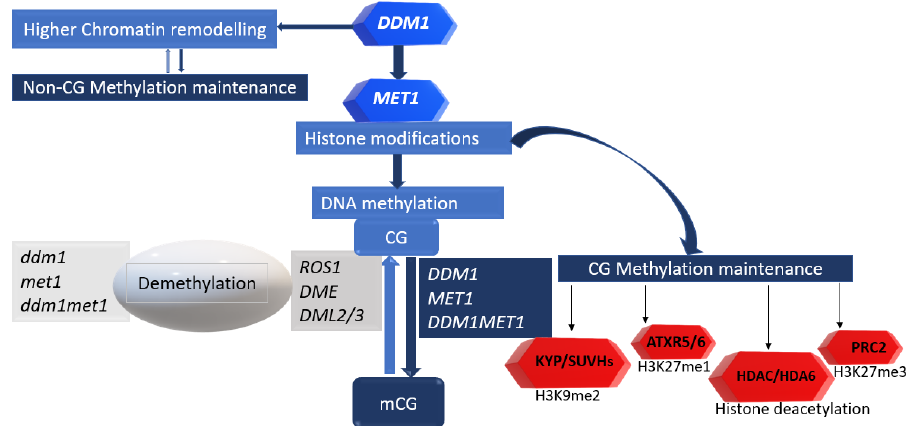
Figure 2. DDM2 ( MET1 ) can act downstream of genic DDM1 activity in the CG context. This could be by direct histone modifications, methylation with specialised histone methyltransferases or deacetylation of histone tails with HDAC proteins, such as HDA6. The dark-blue arrow represents the gene products or proteins that can establish the CG methylation marks (the deep blue and red boxes on the right), while the light-blue arrow represents the genes that can remove these methylation marks (grey boxes on the left). The CG methylation marks can be removed by demethylases ( ROS1 , DME or DMLs ) or by repressing DDM1 and MET1 (grey boxes on the left). The POLYCOMB REPRESSIVE COMPLEX 2 (PRC2) has a histone methyltransferase activity involved in histone H3 lysine 27 trimethylation (H3K27me3). ATXR5 and ATXR6 are plant-specific H3K27me1 methyltransferases involved in female germline development. ROS1 : REPRESSOR OF SILENCING 1 , DME : DEMETER , DML : DEMETER-LIKE , SUVHs: SET DOMAIN-CONTAINING PROTEIN 3, KYP: KRYPTONITE , ATXR5/6: ARABIDOPSIS TRITHORAX-RELATED PROTEIN 5/6, HDAC: HISTONE DEACETYLASE , mCG: CG methylation marks, and CG: removed CG methylation marks. Adapted from [24,45].